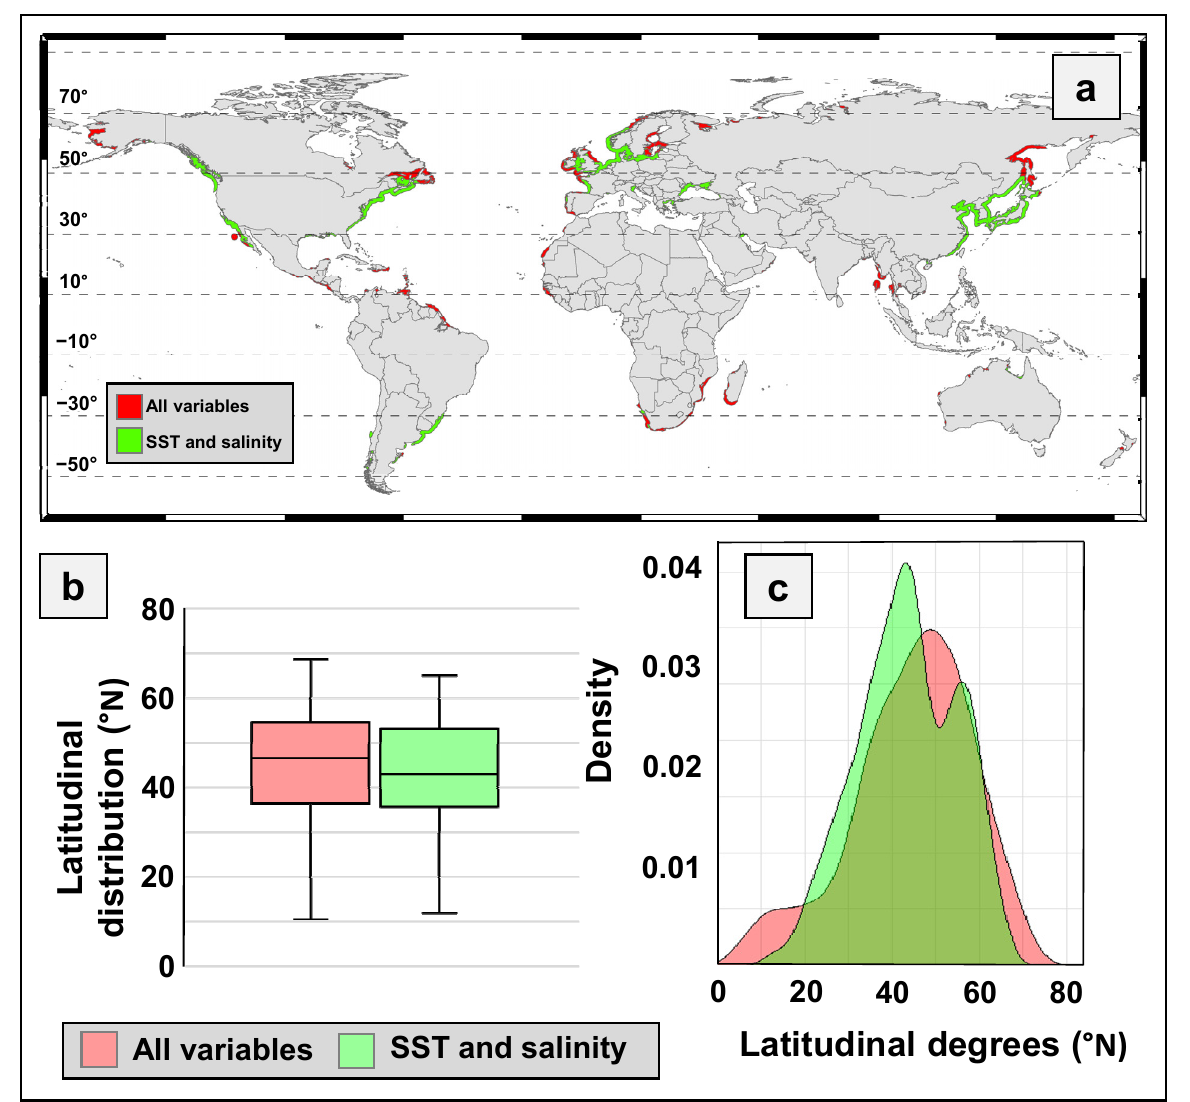
Figure 2. Panel ( a ): Map of the current distribution of Gracilaria vermiculophylla where habitat suita- bility is delimited by a set of environmental descriptors (red areas) and by sea surface temperature (SST) and salinity on their own (green areas). Panel ( b , c ): Representation of the dispersion (box plot graph) and present abundance layout (probability density curves) of the target species in the North- ern Hemisphere in the two tested situations. Variations in distribution are expressed in latitudinal degrees (°).